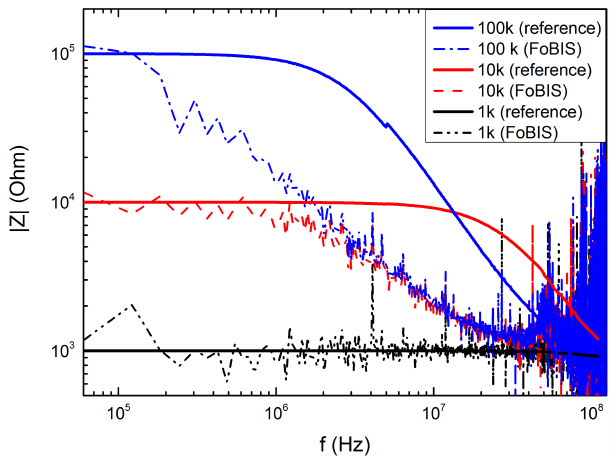
Figure 3. Measurements of test impedances (1 / 10 / 100 k(cid:127) high- precision resistors with small parasitic capacitances ( < 0.4pF)), carried out with a commercial high-precision impedance analyzer (Agilent 4294A) and the FoBIS measurement